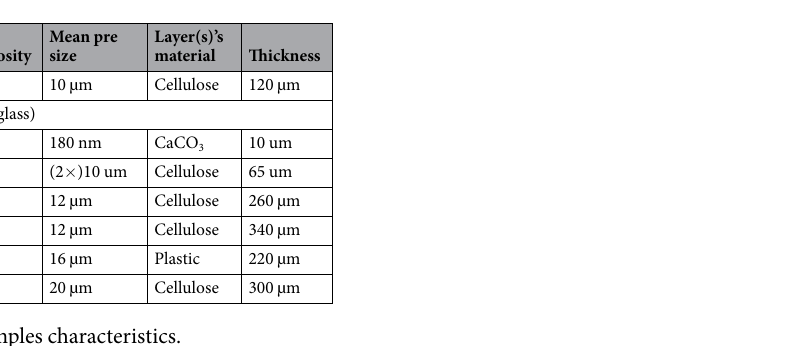
Table 1. Paper samples